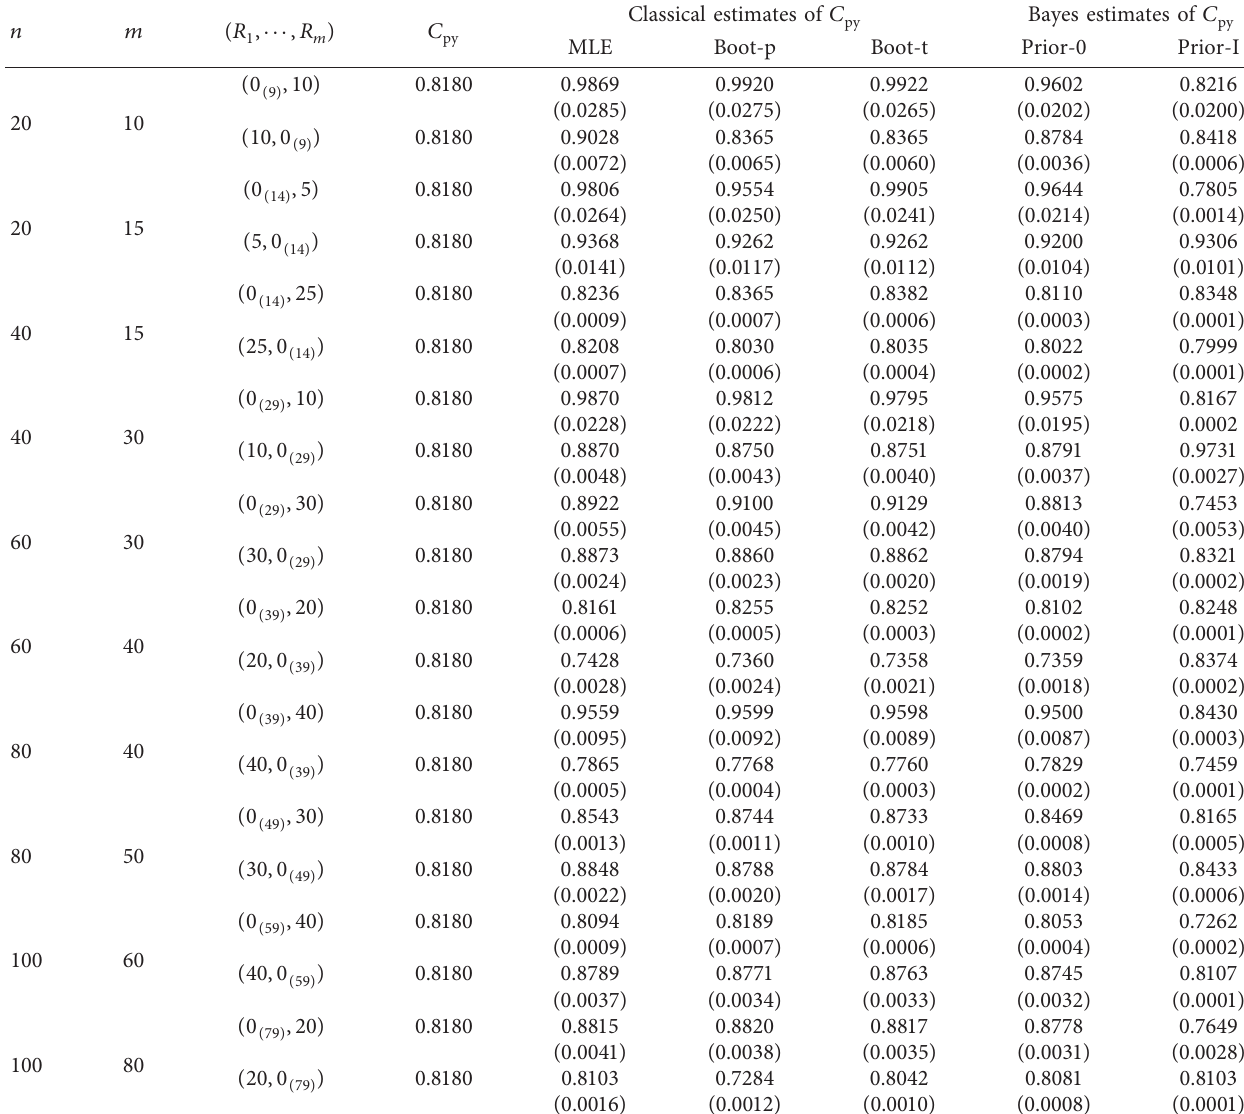
Table 6: True value of C and its classical and the Bayes estimates using different methods of estimation along with their MSEs (in py parentheses) when α � 4 . 40 , θ � 5 . 79 , and c � 0 . 77.